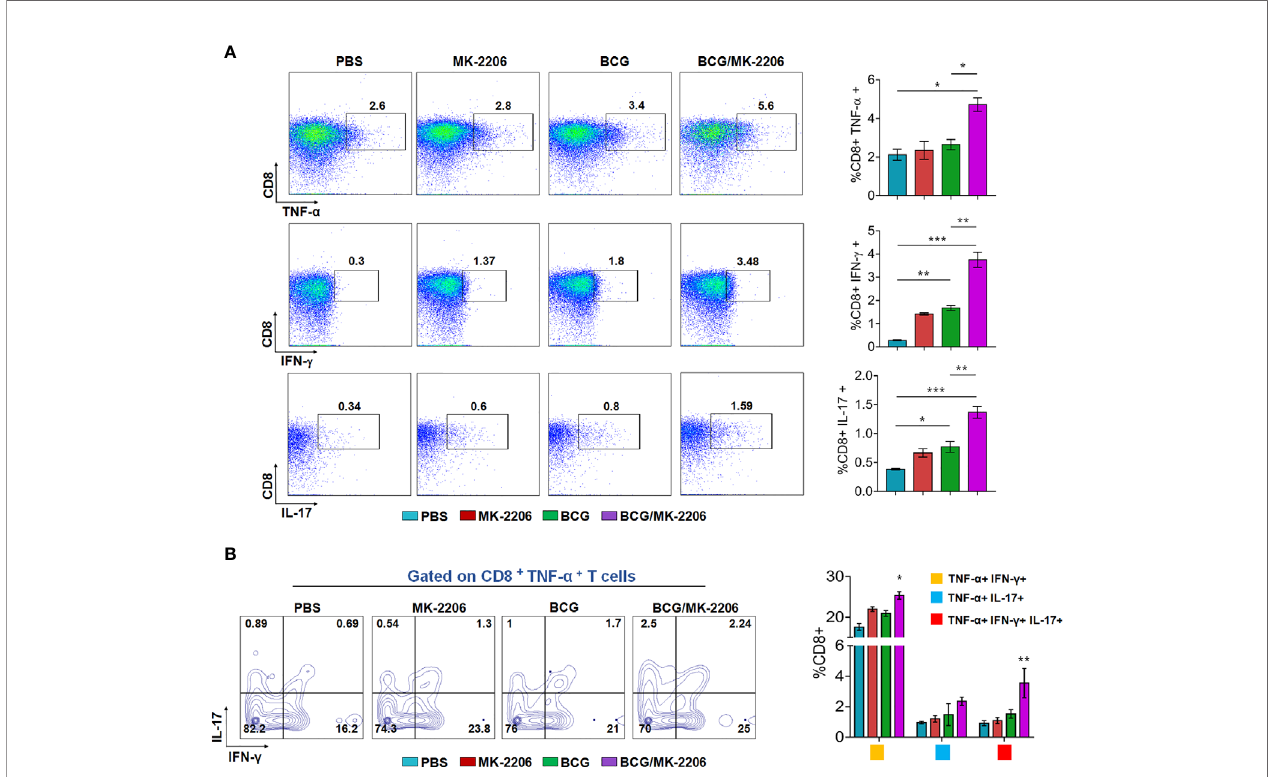
FIGURE 4 | MK-2206 increases antigen-speci fi c multifunctional CD8 + T cell responses in vaccinated mice. Each group of mice was vaccinated as described in Materials and Methods section. Twenty-one days post -immunization, mice from each group (n=5) were euthanized and their splenocytes were incubated ex-vivo with PPD for 48 h in the presence of Golgi stop. (A) Representative dot plots showing the frequency of PPD-speci fi c CD8 + cells producing TNF- a or IFN- g or IL-17 were analyzed by multicolor fl ow cytometry by gating on CD3 + CD8 + lymphocytes. (B) Multifunctional cells were identi fi ed by gating on CD8 + TNF- a + T cells: Representative FACS plots show the frequencies of CD8 + T cells co-expressing TNF- a and/or IFN- g and/or IL-17. Results are displayed as mean ± SEM obtained from a single experiment (n = 5 mice/group). Statistical differences were obtained for the indicated groups. *p < 0.05; **p < 0.01; ***p <